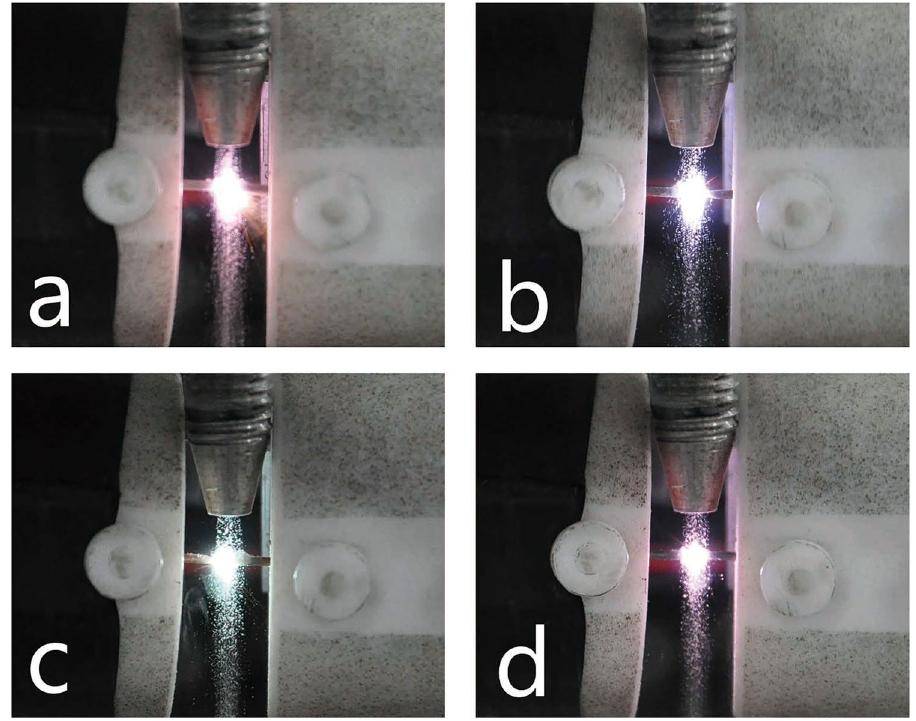
Figure 1. Optical breakdown induced in particle flow with different electrode materials: ( a ) Mo; ( b ) Pt; ( c ) Cu; ( d )